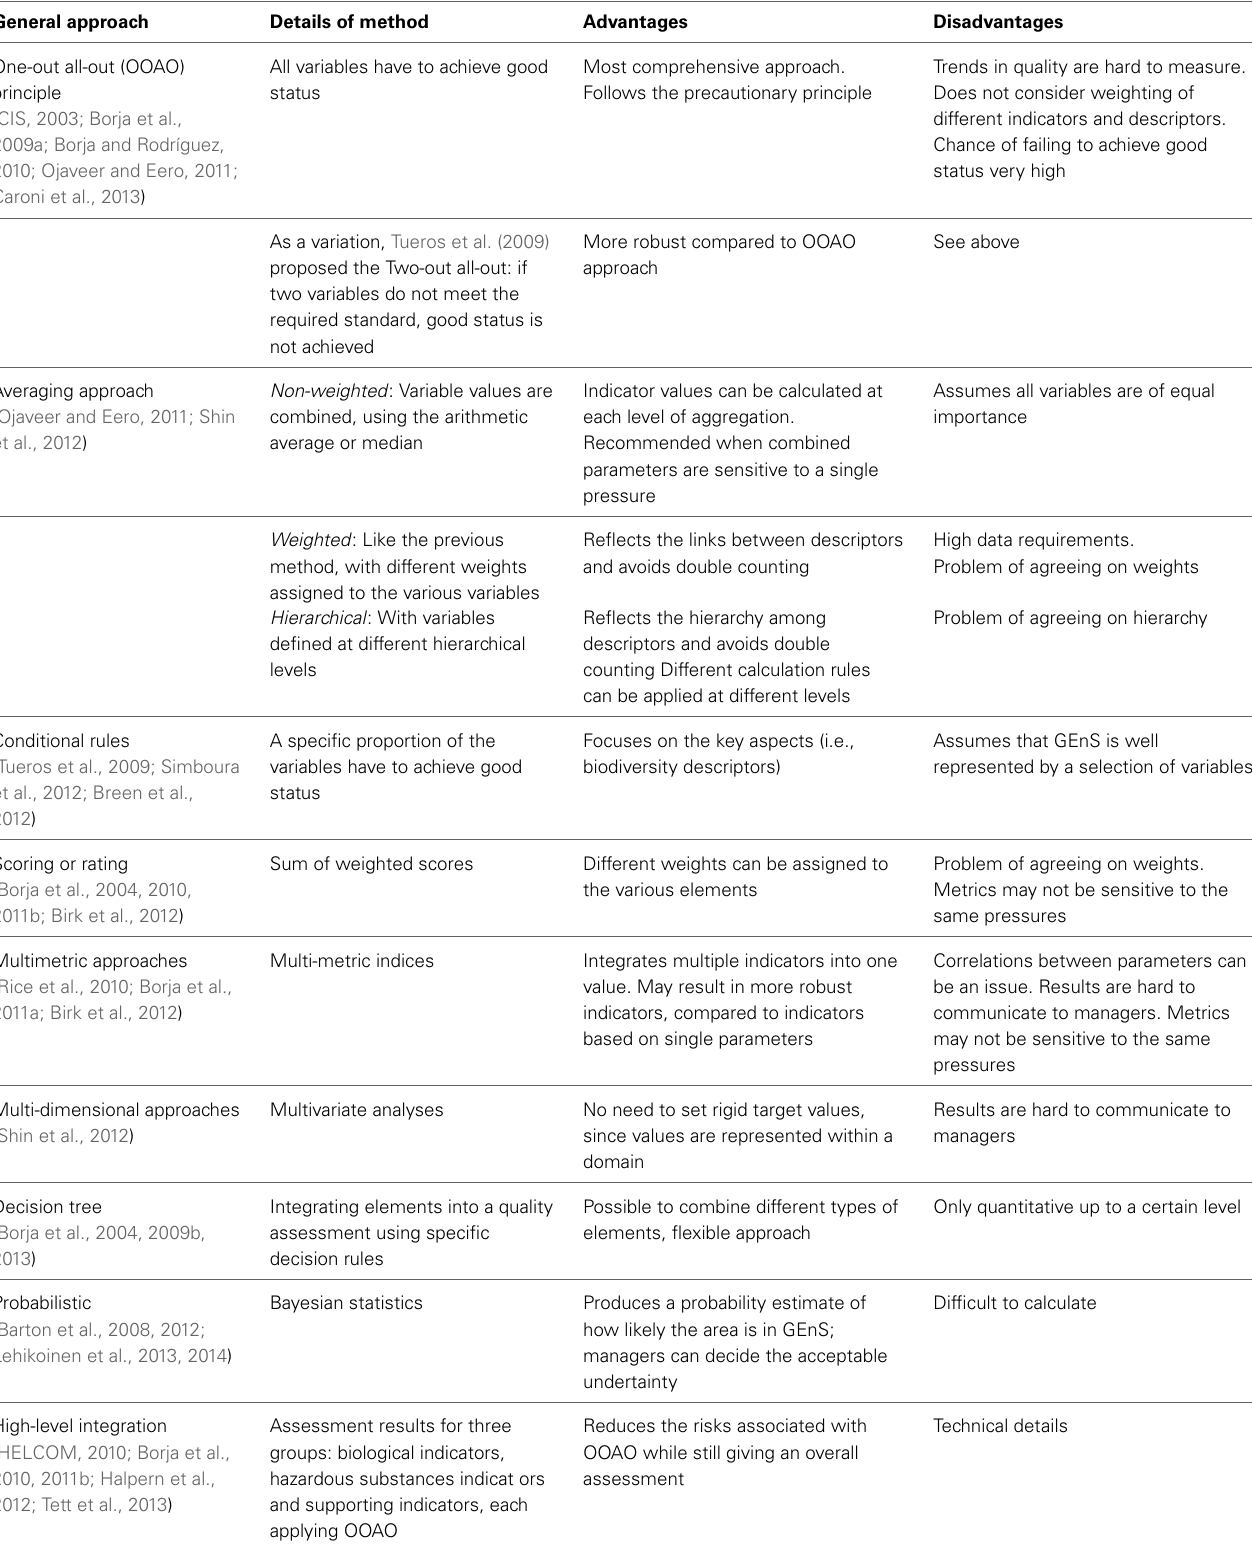
Table 2 | Approaches for combining different metrics, indicators or criteria to assess the status, including the advantages and disadvantages of each approach, as considered by the